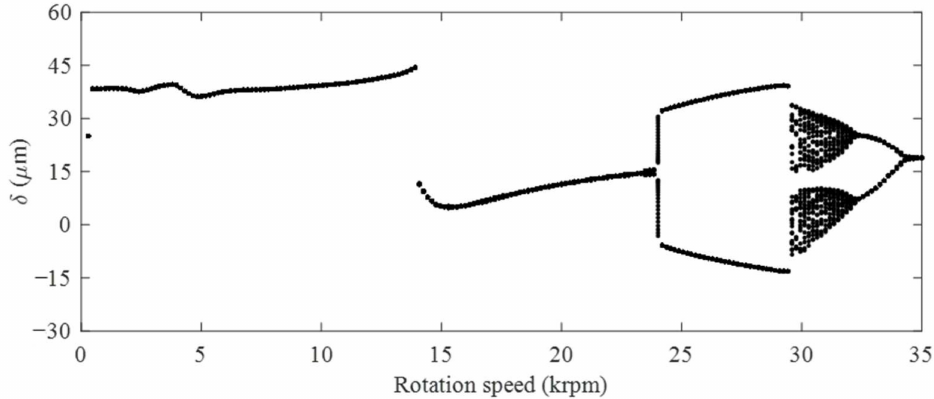
Figure 7. The bifurcation behavior of the gear transmission with a clearance of 0.3 mm. With the increase of the clearance from 0.3 mm to 0.6 mm, a chaotic motion is observed again in the medium-speed zone, but the corresponding speed range of the chaotic motion changed to 15,296–17,214 rpm, as shown in Figure 8. Compared with the case without clearance, the speed corresponding to quasi-periodic motion is still delayed, but it is advanced compared with the case with clearance of 0.3 mm. Compared with the case with 0.3 mm clearance, the speed corresponding to chaotic, 2 T-period and T-period in the high speed are advanced by a certain amount. These comparison results show the nonlinear behavior in the low speed of the gear system is insensitive to the clearance in revolute pair. But it will cause the appearance and disappearance of some nonlinear behaviors in the middle-speed and high-speed area, or change the speed corresponding to the nonlinear behavior of the gear transmission